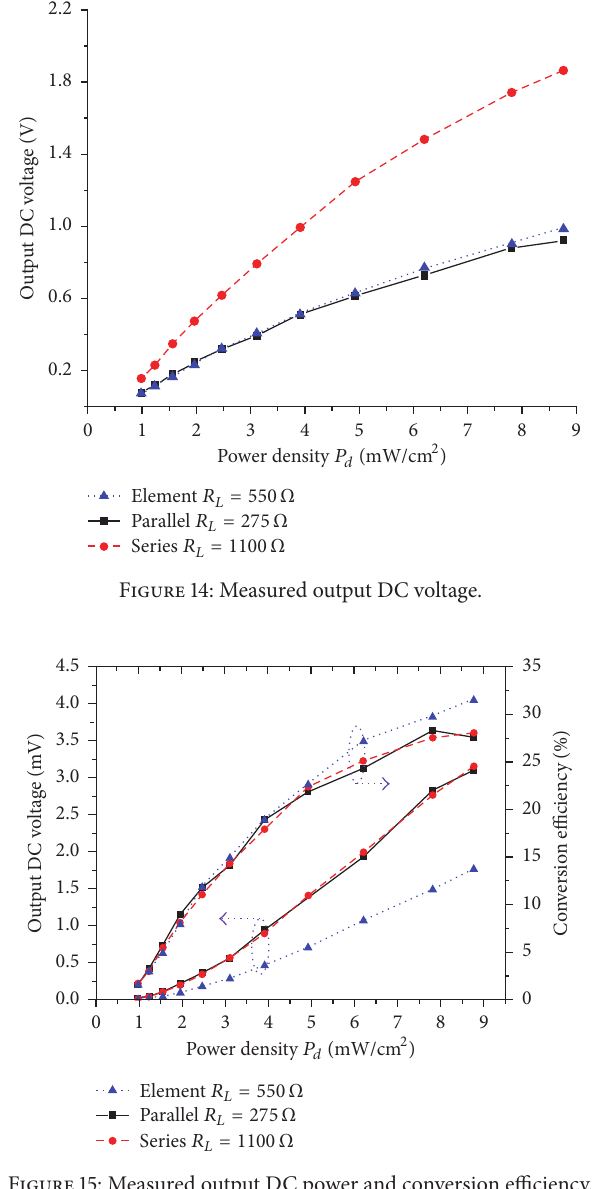
Figure 15: Measured output DC power and conversion